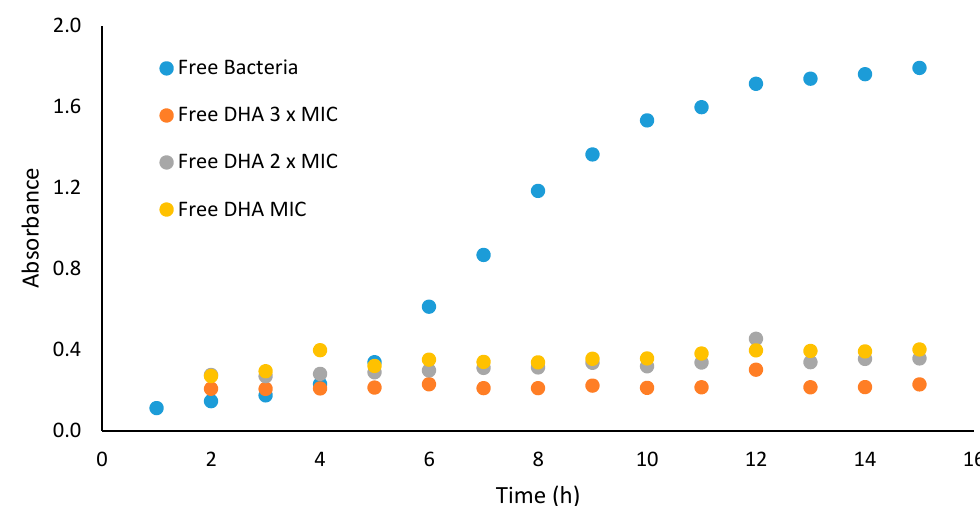
Figure 2. Graphic representation of the growth curve study results of DHA against S. aureus ATCC 25923.